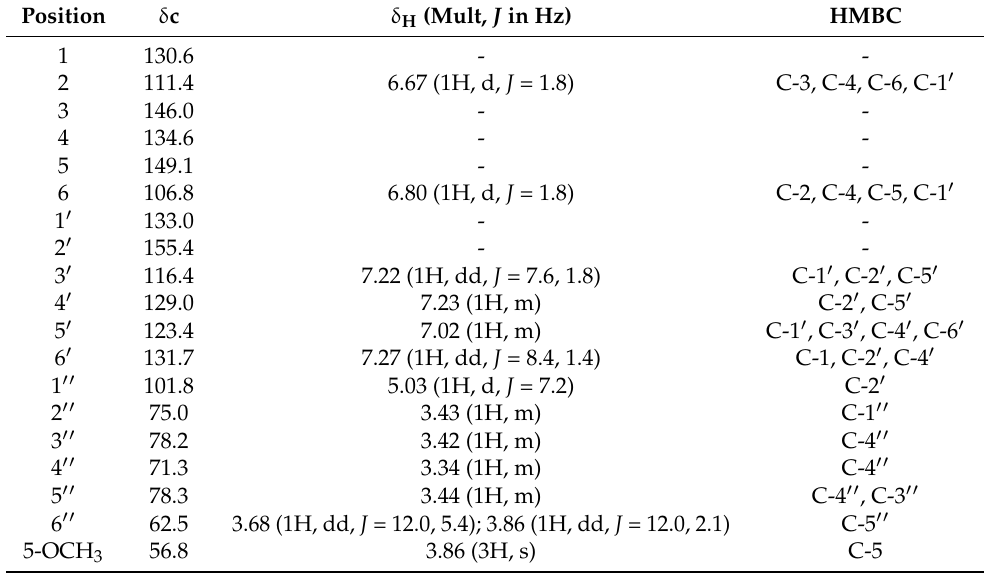
Table 2. NMR spectral data of 3,4-dihydroxy-5 1 -methoxybiphenyl-2 1 - O - β - D -glucopyranoside ( 13 ) ( δ values, in CD 3 OD, J in